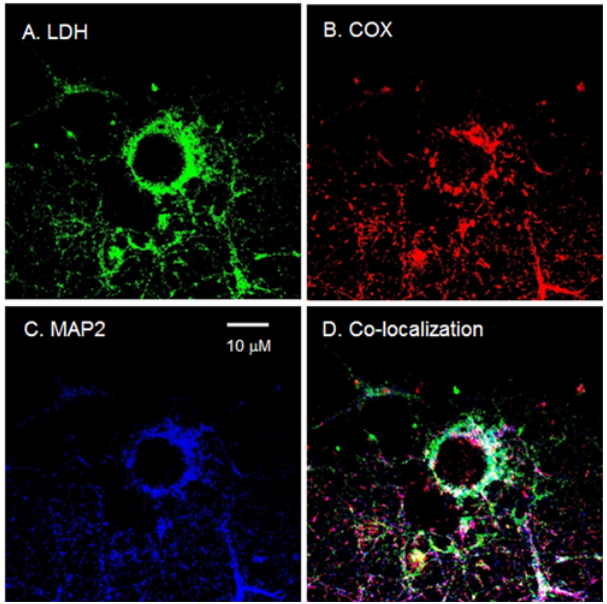
Figure 9. Immunohistochemical images demonstrating mito- chondrial LDH in neurons cultured from rat hippocampus and cortex. Superposition of signals from probes for LDH (A, green), COX (B, red) and MAP2 (C, blue) showed clear colocalization (D, yellow/ white) in neuron cells. Scale bar=10 m m.